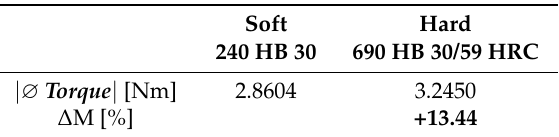
Table 12. Average spindle torque for soft and hard machining with standard inserts of type 1030 with percentage increase.